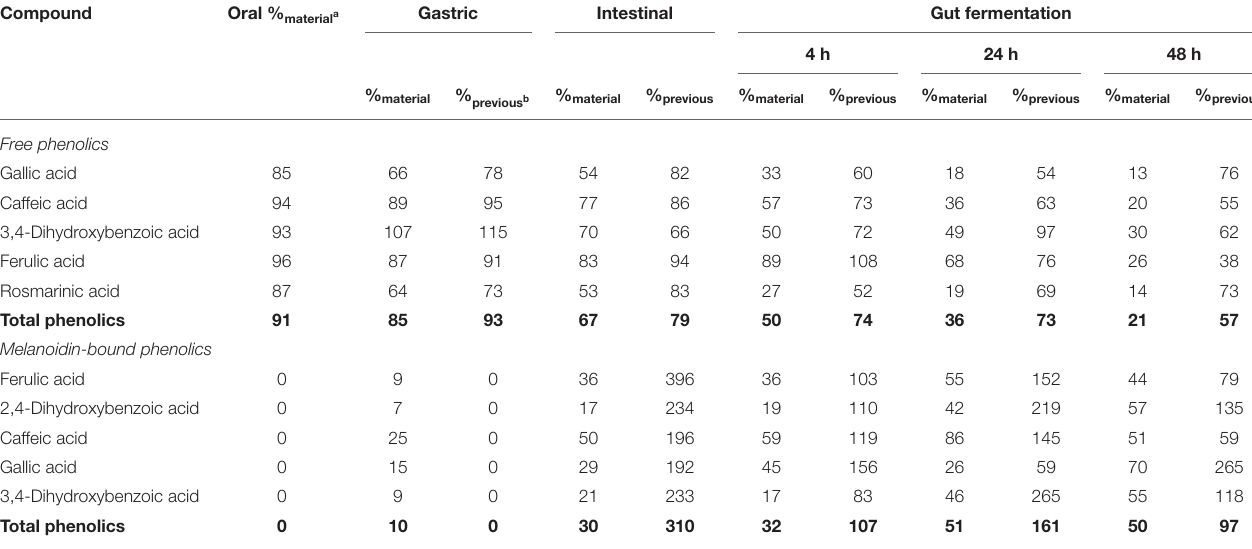
TABLE 4 | Bioaccessibility (%) of free and melanoidin-bound phenolic compounds from bread during simulated digestion (oral, gastric, and intestinal steps) and gut fermentation.